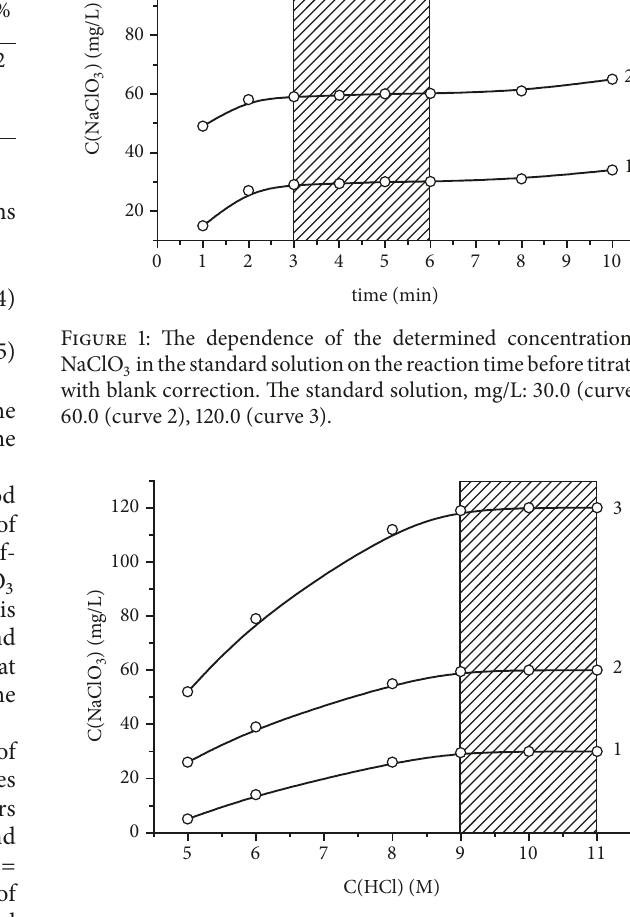
Figure 2: The dependence of the determined concentration of NaClO 3 in a standard solution on the concentration of HCl with the reaction time before titration of 4 min. The standard solution, mg/L: 30.0 (curve 1), 60.0 (curve 2), 120.0 (curve 3).